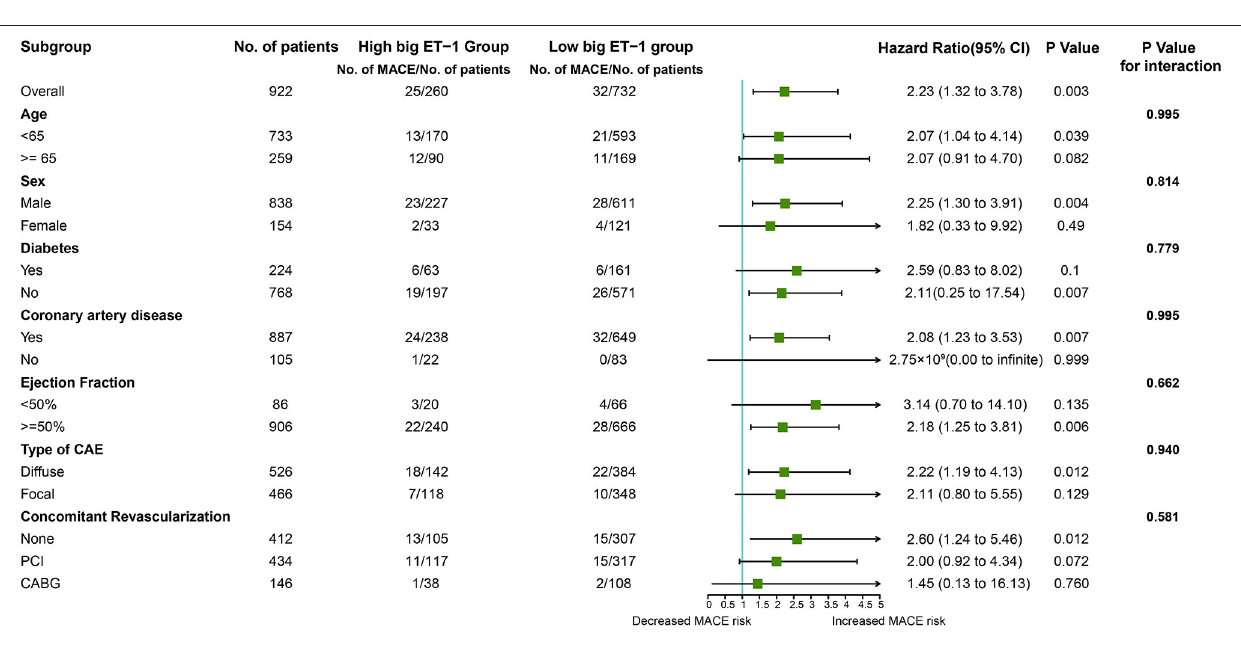
FIGURE 4 | Hazard ratio of MACE among subgroups. ET,